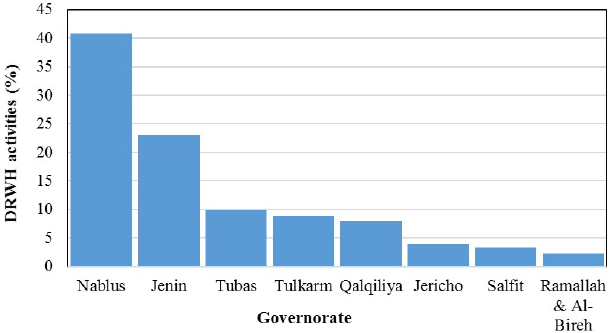
Figure 11. Percentages of DRWH activities in the northern gover- norates of the West